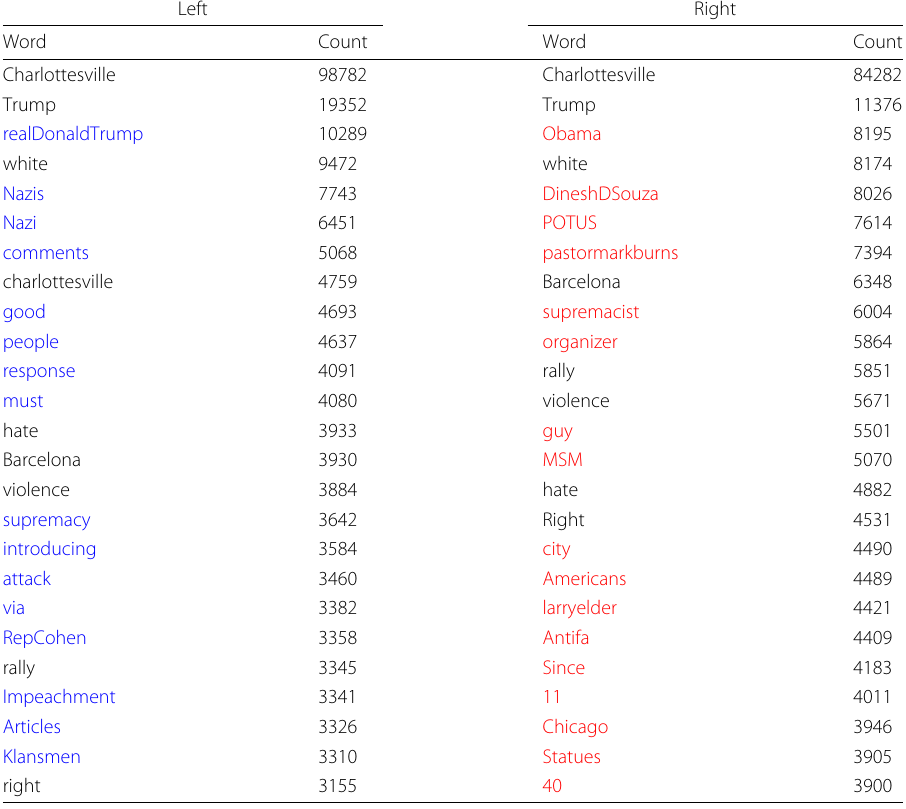
Table 4 The 25 most common words for nodes with negative (i.e., Left) and positive (i.e., Right) media PCA